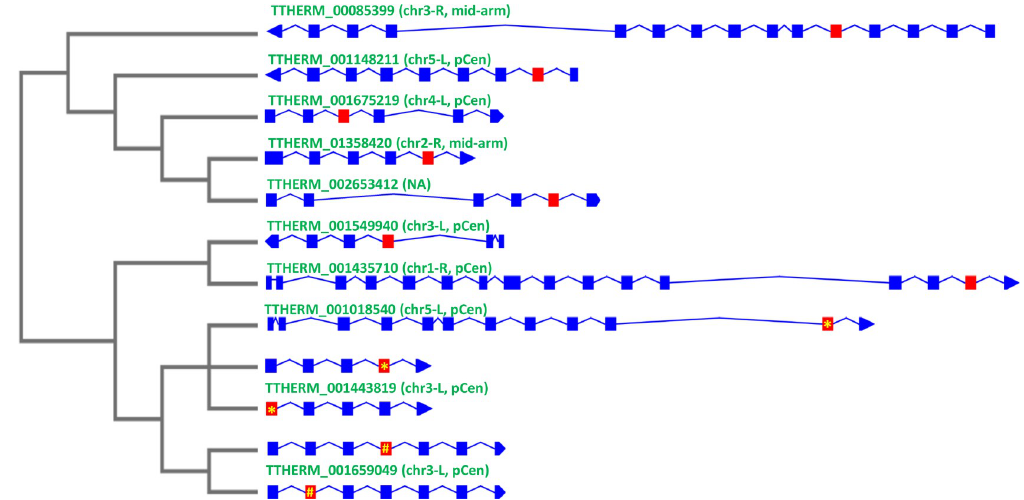
Fig 7. Phylogeny and MIC chromosome distribution of 12 nearly identical 90-bp exons in different T . thermophila LRR genes give evidence of extensive ectopic recombination. Right: intron/exon diagram of the 10 LRR genes containing the twelve 90-bp exons (shown in red) that share between 88 and 90 identical nucleotides. Listed above each gene: MIC chromosome location. L or R indicates the left or right arm of chromosome. Left: a maximum likelihood phylogenetic tree based exclusively on these twelve 90-bp exons. Note that (a) this is the largest group of nearly identical 90-bp exons and (b) TTHERM_001443819 and TTHERM_00001659049 both have 2 exons that belong to this group. Identical 90-bp exons share the same symbol: yellow asterisk ( � ) or number sign (#). chr3, Chromosome 3; LRR, leucine-rich repeat; MIC, micronucleus; mid-arm, near the middle of chromosome arms; NA, not available (the gene is located in still unassembled region of MIC genome); pCen, pericentromeric